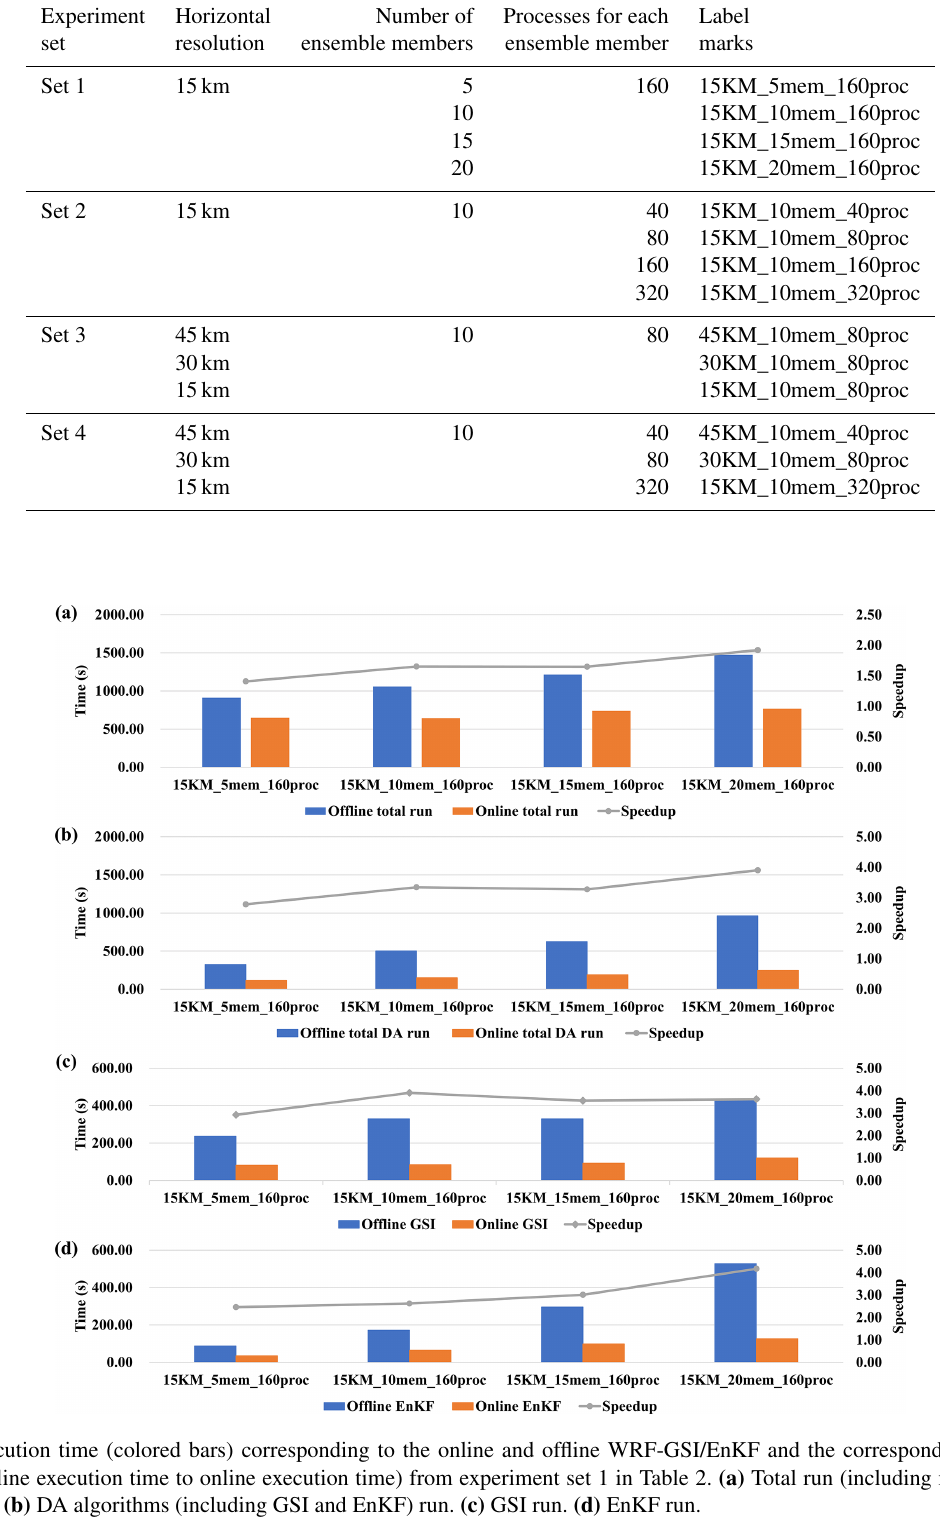
Table 2. Setup of four experiment sets in terms of horizontal resolution, number of ensemble members and number of processes.